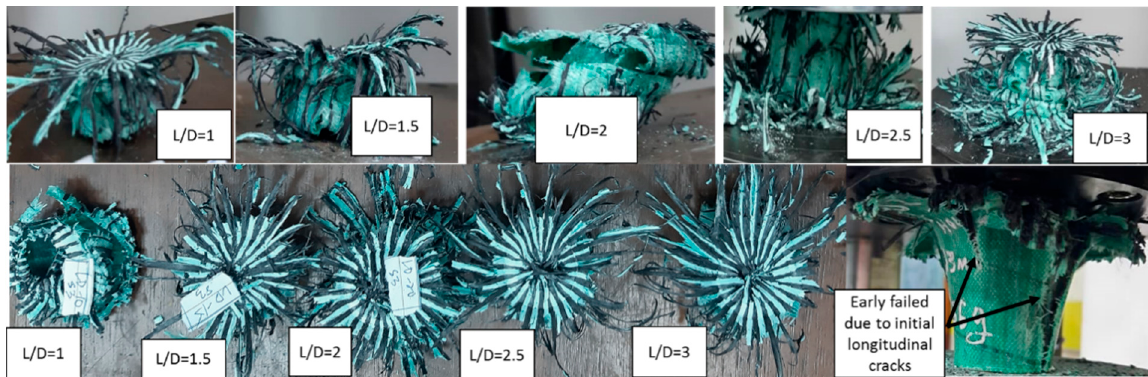
Figure 6. The deformed shape of specimens in the experimental test.